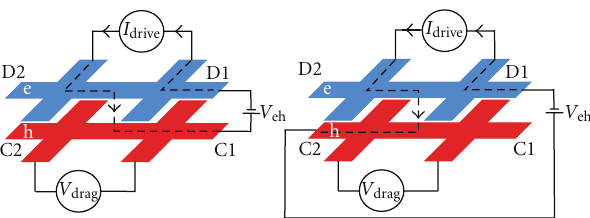
Figure 8: Diagram showing that a sign reversal of any error in drag due to excitation current leaking between layers is expected when biasing points (named C1, C2, D1, and D2) are altered, as direction in drag layer changed. A little bit of the drive current may be leaking into the other layer and flowing through a parallel path that includes part of the second layer. The resistive drop due to this would appear between the voltage probes. But it is possible to decide whether the measured voltage is due to this. If we change the point at which the second layer is grounded, the path of the leakage current would then be reversed causing the measured voltage to change. Thus, by shifting the point at which the “drag layer” is voltage referenced, we can verify if the measured voltage was due to leakage or